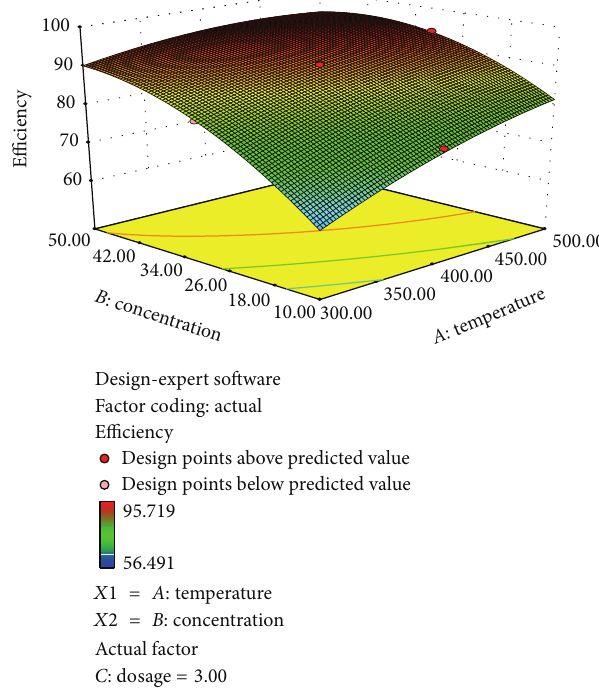
Figure 3: Combined effect of factors 𝐴 - 𝐵 on response 𝑌 1